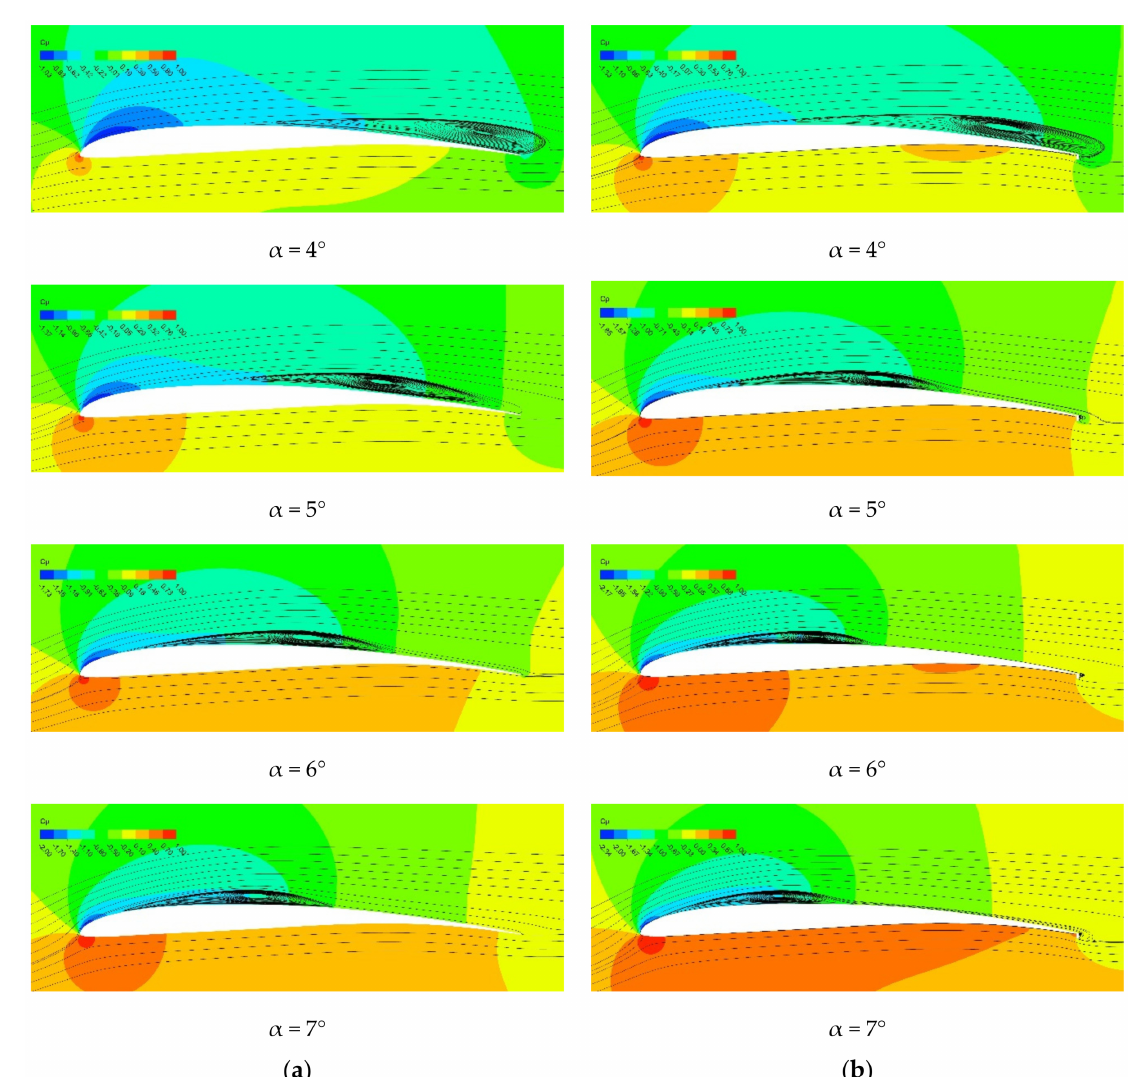
Figure 32. Pressure coefficient and streamline distributions at Re = 4.0 × 10 4 : ( a ) Airfoil A; ( b ) Airfoil